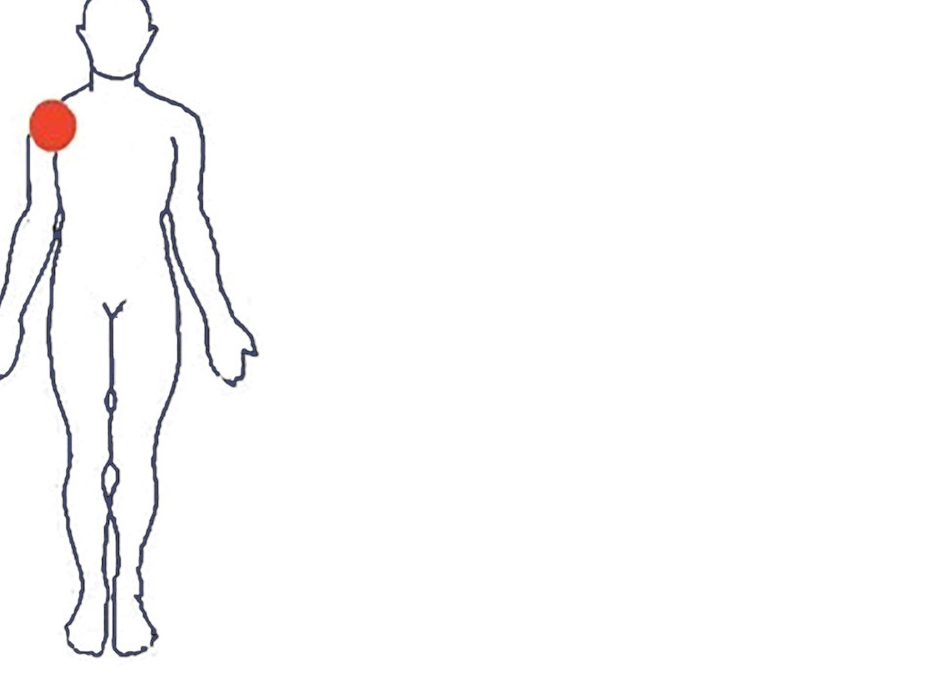
Figure 1. Body chart at pain onset. Bright red indicates the initial location of the painful body area.